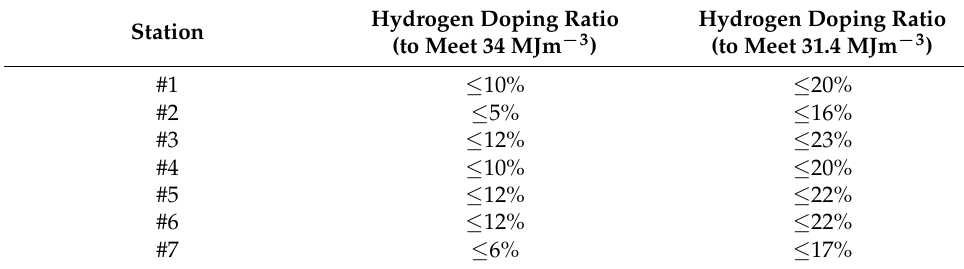
Table 5. Requirements for hydrogen mixing ratios of different gas source